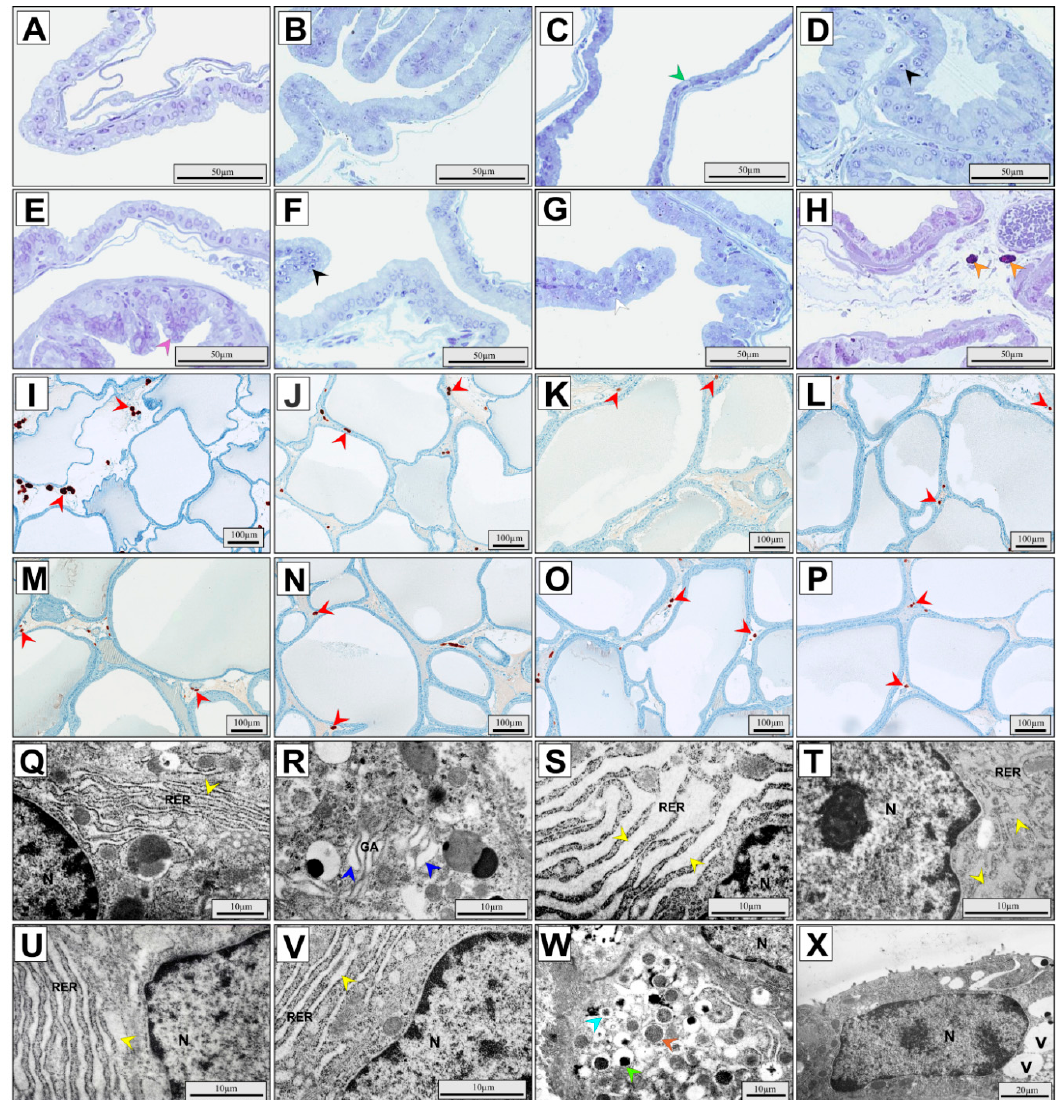
Figure 3. Representative light micrographs of toluidine-blue-stained glandular epithelium ( A – H ), immunolocalization of CD117 + cells in the stroma ( I – P ), and electron micrographs of epithelial luminal cells ( Q – X ) of rat ventral prostate. Normal glandular epithelium in the control group ( A ); slight changes of the epithelium in the RTP group ( B ); epithelial atrophy (green arrowhead) in the RCP group ( C ); prominent nucleolus in the nucleus (black arrowheads) and focal atypical hyperplasia (violet arrowhead) of the CMP group ( D ), the RMP group ( E ), and the TMP group ( F ); focal atypical hyperplasia without features of prostatic intraepithelial neoplasia (white arrowhead) in CMP/R group ( G ); mast cells (orange arrows) in the TMP/R group ( H ); CD117+ cells in the stroma (red arrowheads) of the CMP group ( I ), the TMP group ( J ), the control group ( K ), the RTP group ( L ), the RCP group ( M ), the RMP group ( N ), the CMP/R group ( O ), and the TMP/R group ( P ); normal cisterns of the rough endoplasmic reticulum (yellow arrowhead) in the control group ( Q ); slightly distended cisterns of the Golgi apparatus (blue arrowheads) in the RMP group ( R ); distended cisterns of the rough endoplasmic reticulum (yellow arrowheads) in the CMP group ( S ), the TMP group ( T ), the CMP/R group ( U ), and the TMP/R group ( V ); condensed (light green arrowhead), flocculent (brown arrowhead), and star-shaped (light blue arrowhead) secretions in the RTP group ( W ); epithelial atrophy and intracellular vacuoles in the RCP group ( X ). CMP: rats treated with cyclosporin A, mycophenolate mofetil, and prednisone; CMP/R: rats treated with cyclosporin A, mycophenolate mofetil, and prednisone in the first three months and rapamycin in the last three months; GA: Golgi